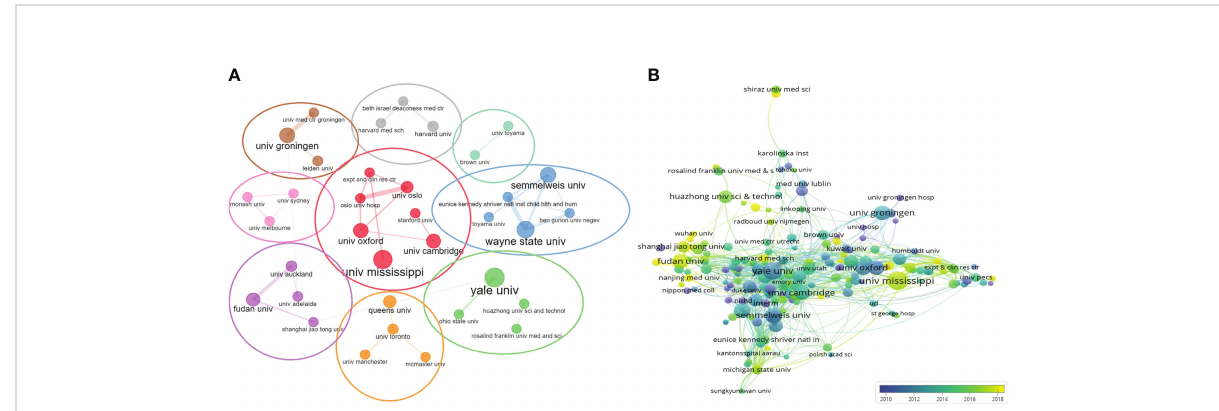
FIGURE 4 Network map of universities/institutions collaboration. (A) The network visualization of universities/institutions (The thickness of the lines indicates the strength of cooperation between universities/institutions). (B) Dynamics and trends of universities/institutions over time.